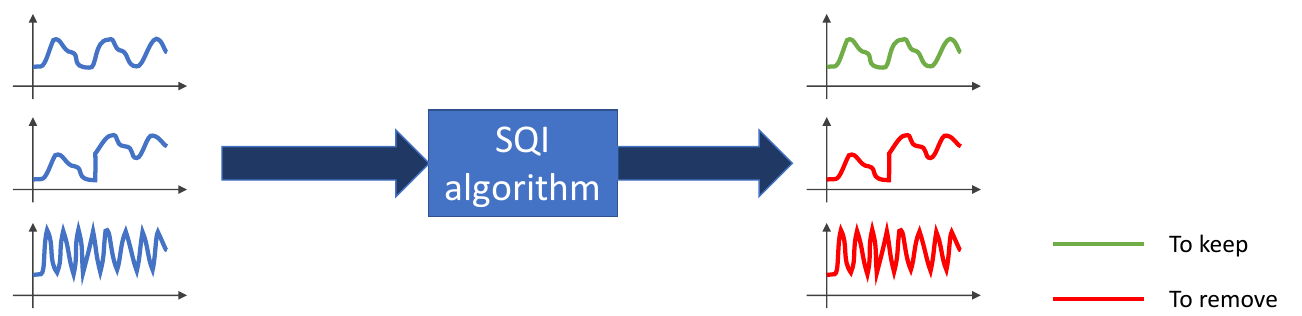
Figure 5. Example of application of an SQI assigning a quality score or label to filter irrelevant data. In this figure, an SQI assigns a “bad-quality” label (in red) for a noisy PPG signal or a signal affected by a motion artefact to be suppressed and a “good-quality” label (in green) for the signals to be kept in the